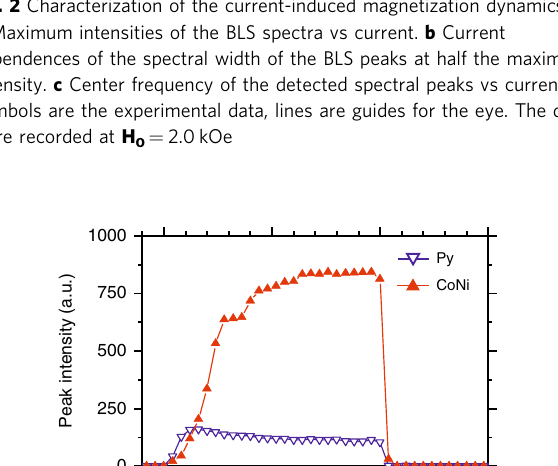
parallel to the static fi eld H 0 merge at the wavevector k = 0, at the frequency f FMR of the uniform-precession ferromagnetic reso- nance (FMR). The frequency of the branch with k ⊥ H 0 mono- tonically increases with k , while the branch with k || H 0 exhibits a minimum f min at fi nite k due to the competition between the dipolar and the exchange interactions. The frequencies obtained